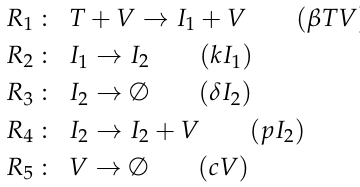
Figure A3. Reactions of Baccam model [14] with delayed virus production.